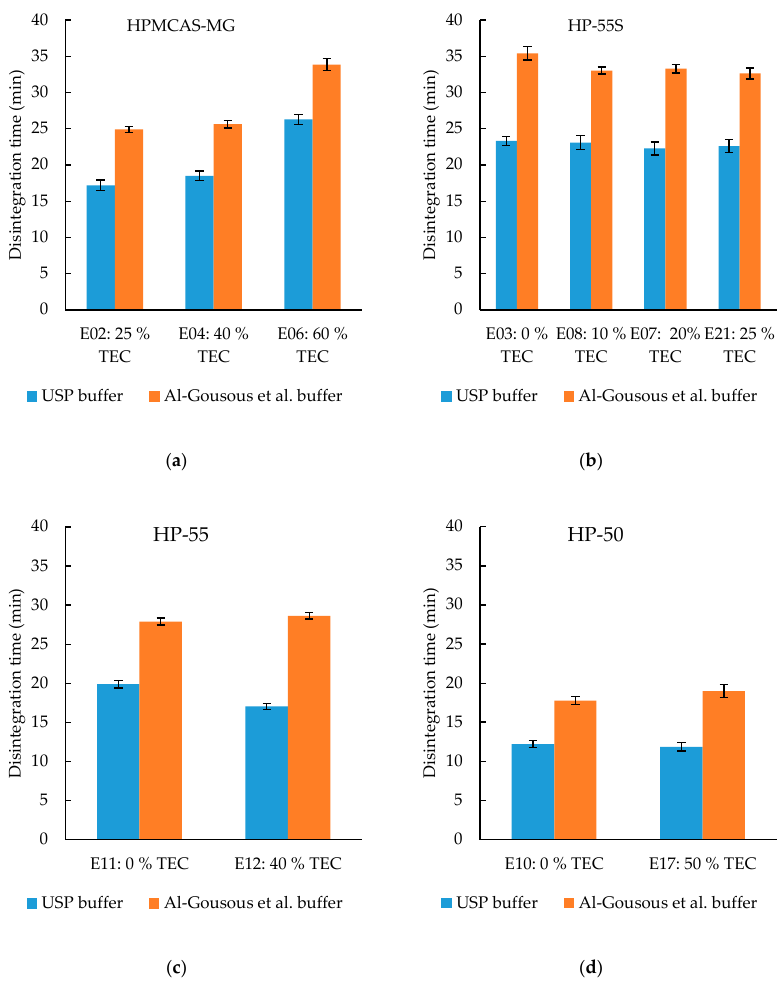
Figure 7. Effect of plasticizer content on the disintegration time in different formulations: ( a ) HPMCAS-MG formulations; ( b ) HP-55S formulations; ( c ) HP-55 formulations; ( d ) HP-50 formulations. Given are average disintegration times ± SD; n = 6. TEC content is based on dry polymer weight.